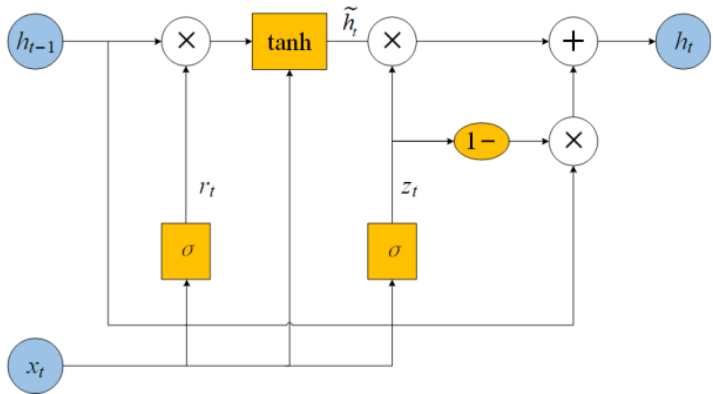
Figure 2. Inner structure of GRU cell [23].